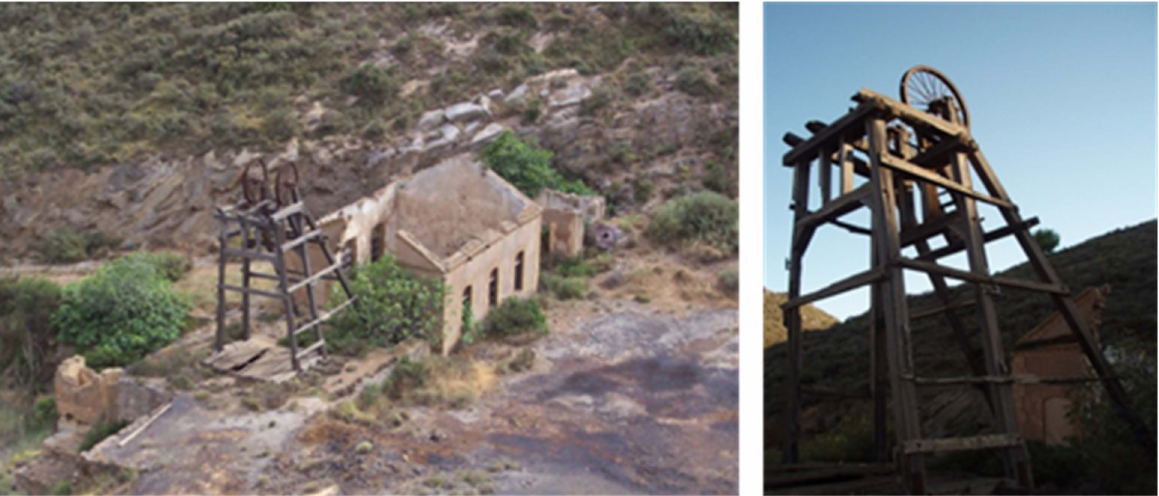
Figure A1. Deterioration of the study areas: ( a ) Waste materials generated by the mining activity in La Uni ó n (MU, Spain), ( b ) industrial discharge and rubble in the Guadalent í n riverbed in Lorca.